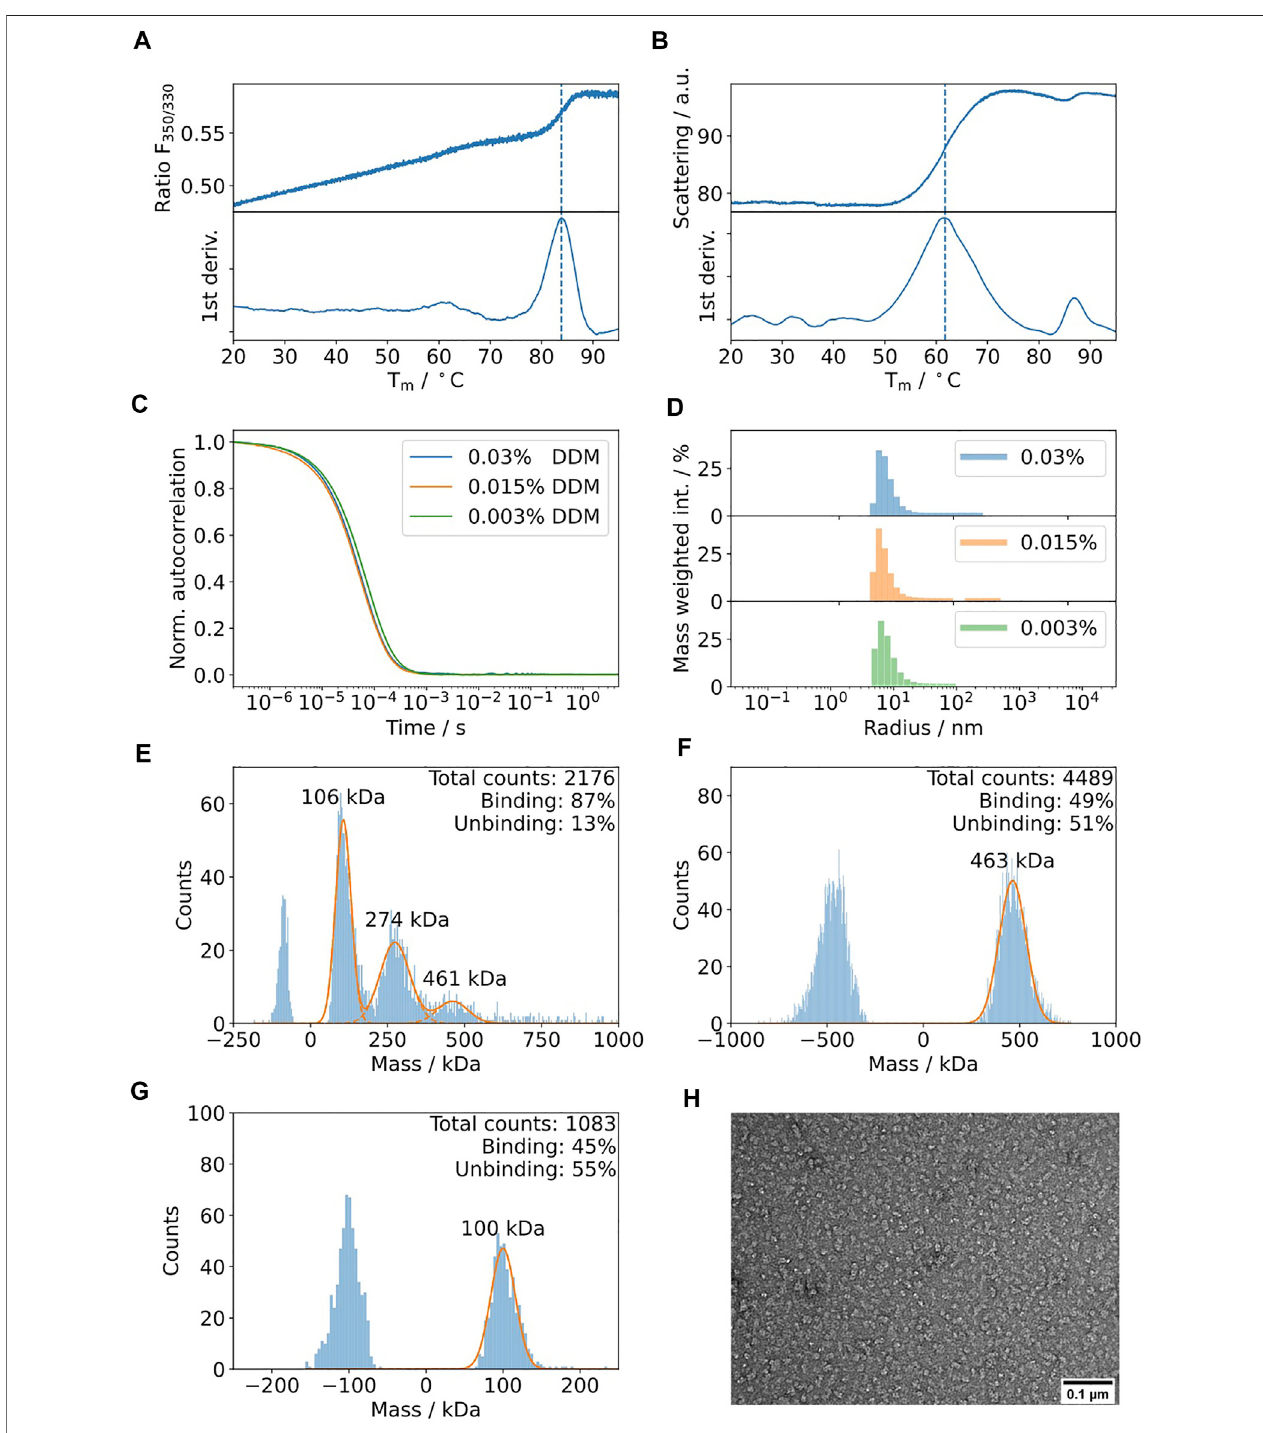
FIGURE 7 | Biophysical characterization of TolC in detergent DDM. (A) nDSF of 5 μ M TolC in 0.03% DDM buffer with a heating rate of 1 ° C/min indicates a high thermal stability with a weak transition around 84 ° C. (B) The scattering curve acquired during the nDSF indicates aggregation at a lower temperature of 62 ° C. (C) The DLS autocorrelation curves suggest similar polydispersity and hydrodynamic radii for DDM concentrations in the range of 0.003 and 0.03%. (D) Mass weighted histograms forthe curves displayed in Figure 7C(E) .Mass photometry of150 nM TolC in thepresence of0.003%DDM.Three bands aredetectable at 106, 274, and461 kDa.Controlmeasurementsat0.03% (F) and0.003%DDM (G) suggestthatthebandsat106and461 kDacanbeassignedtoDDM.Thebandat274 kDacan be assigned to the TolC-DDM complex (the theoretical mass of TolC is 162 kDa). (H) Negative staining electron micrographs of TolC at 0.015 mg/ml using 40000 x magni fi cation on a Jeol 200 kV cryo-TEM using in-house carbon-coated grids.